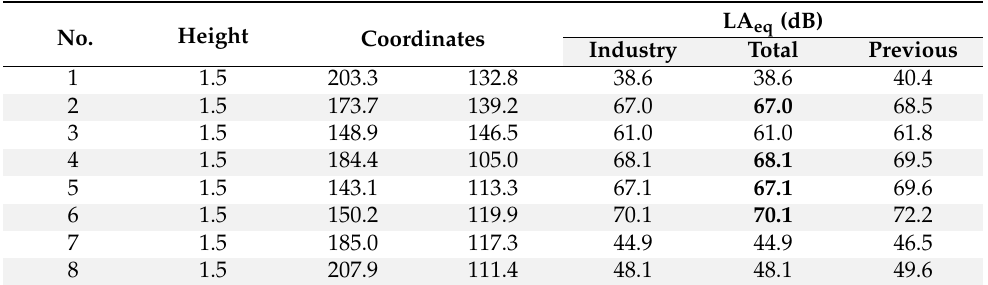
Table 9. Table of calculated values of measured points with the simultaneous deployment of machines shown as previous values; after the separation of excavation work from material removal, the values shown are only for excavations with an excavator. Table 10. Expected sources of construction noise.